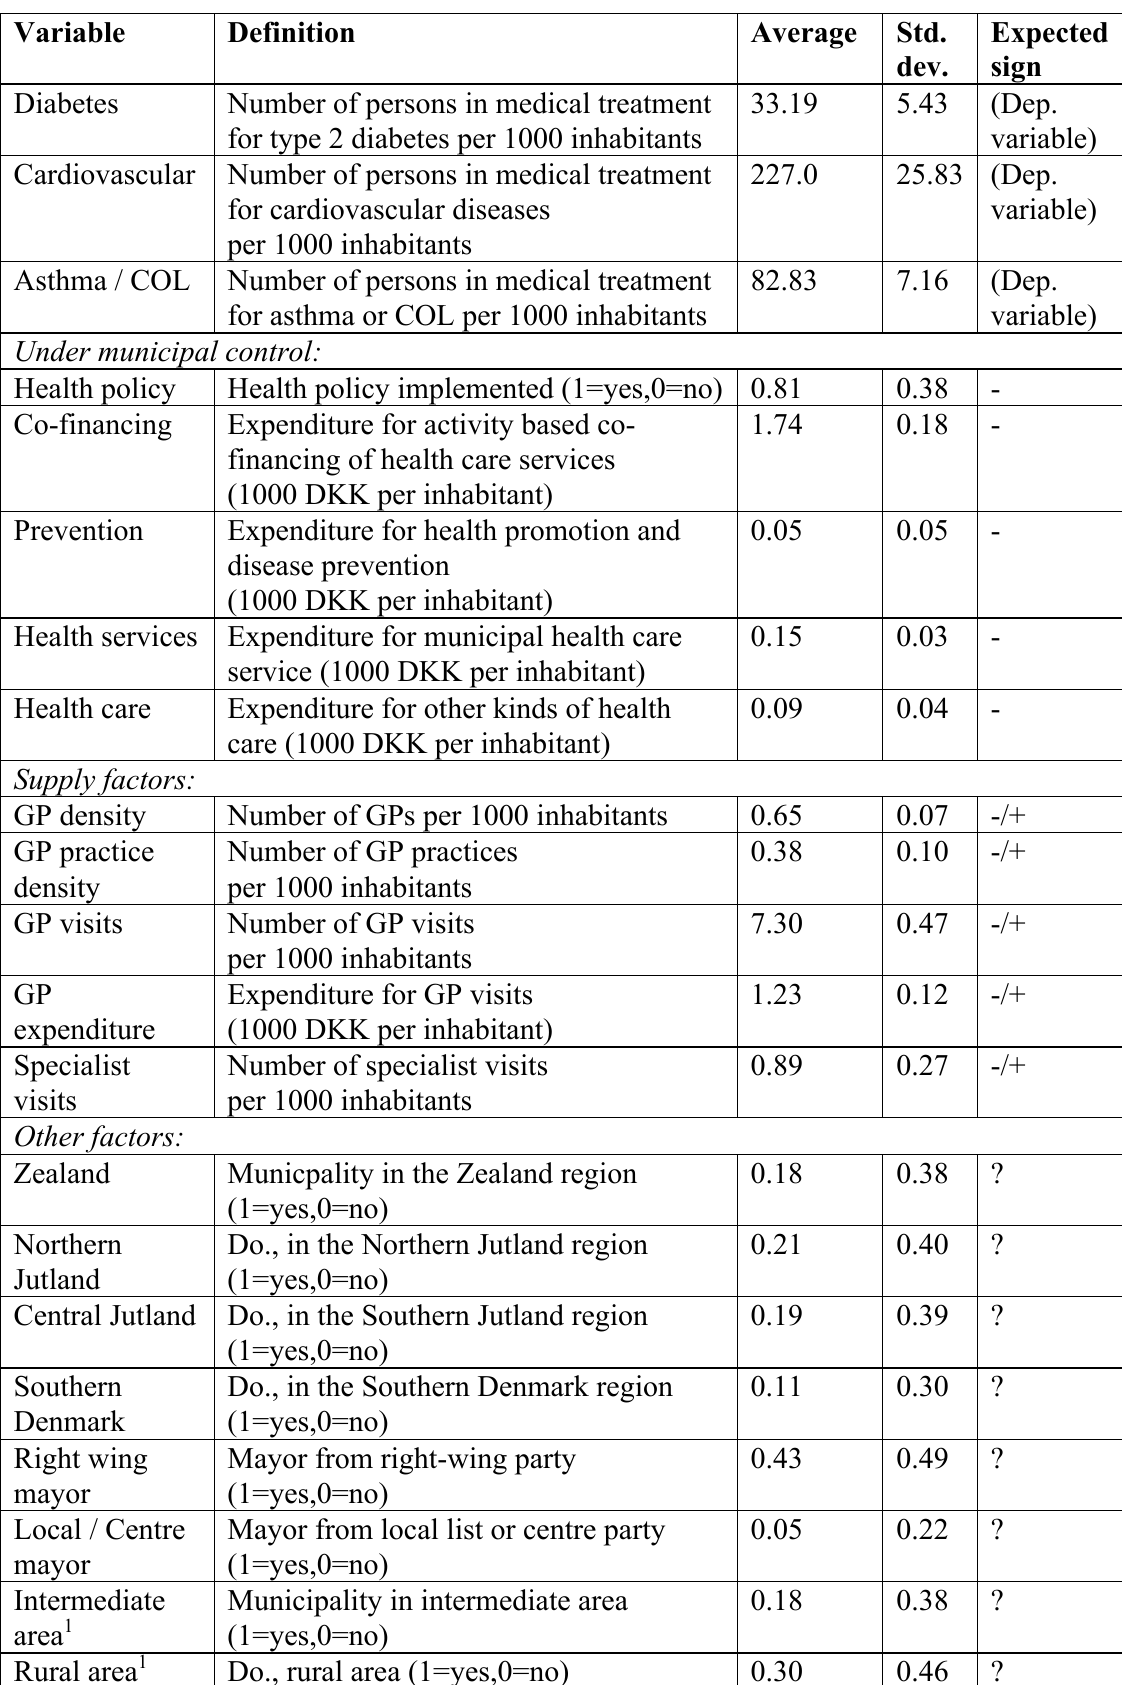
Table 1. Description of